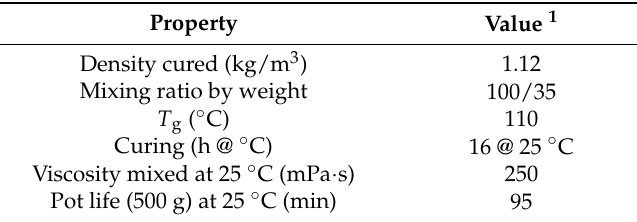
Table 2. Epoxy resin used in H2